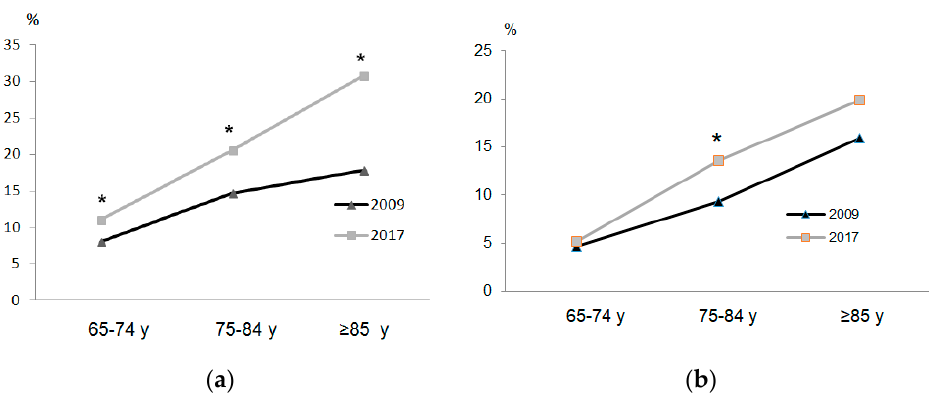
Figure 3. Di ffi culty going up or down 12 stairs: women ( a ) and men ( b ). * p < 0.05. Figure 3. Difficulty going up or down 12 stairs: women ( a ) and men ( b ). * p < 0.05. Figure 3. Difficulty going up or down 12 stairs: women ( a ) and men ( b ). * p < 0.05. Figure 3. Difficulty going up or down 12 stairs: women ( a ) and men ( b ). * p < 0.05.